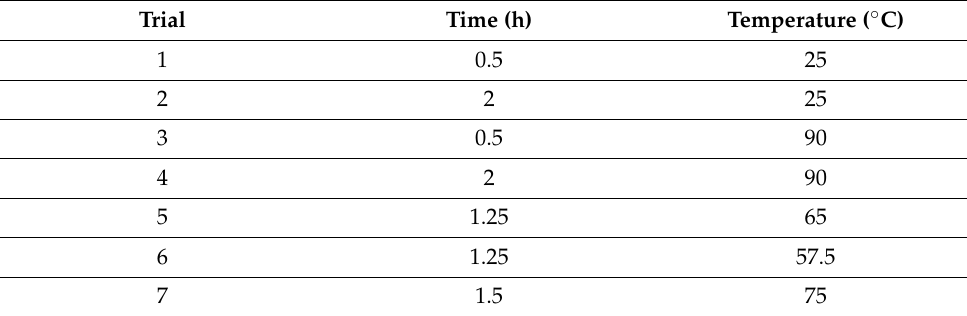
Table 8. Test conditions for water